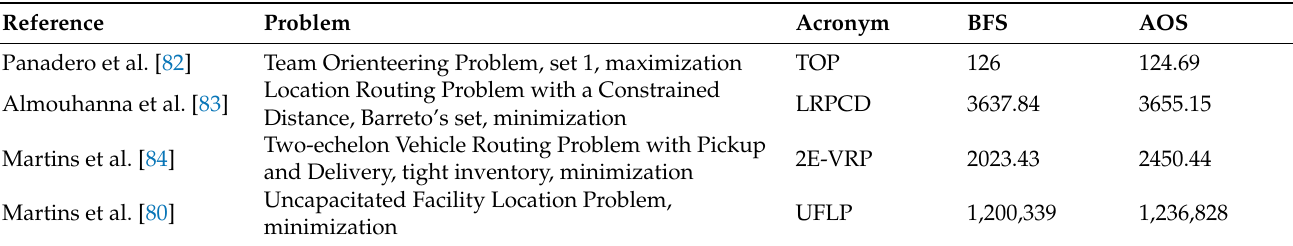
Table 3. Selected problems solved using an AO